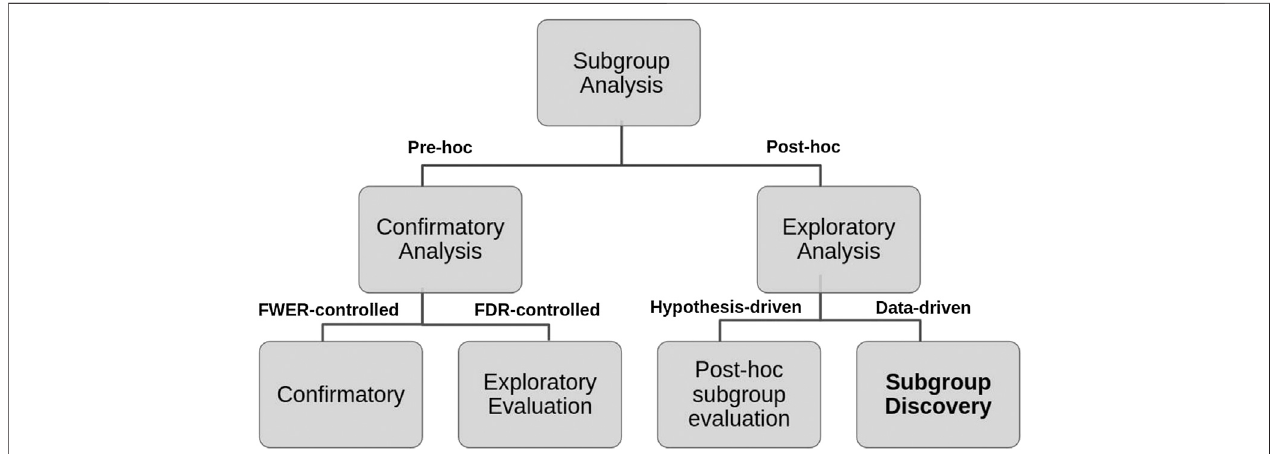
FIGURE 2 | Hierarchical tree representing the two layers classi fi cation of SA tasks and criteria